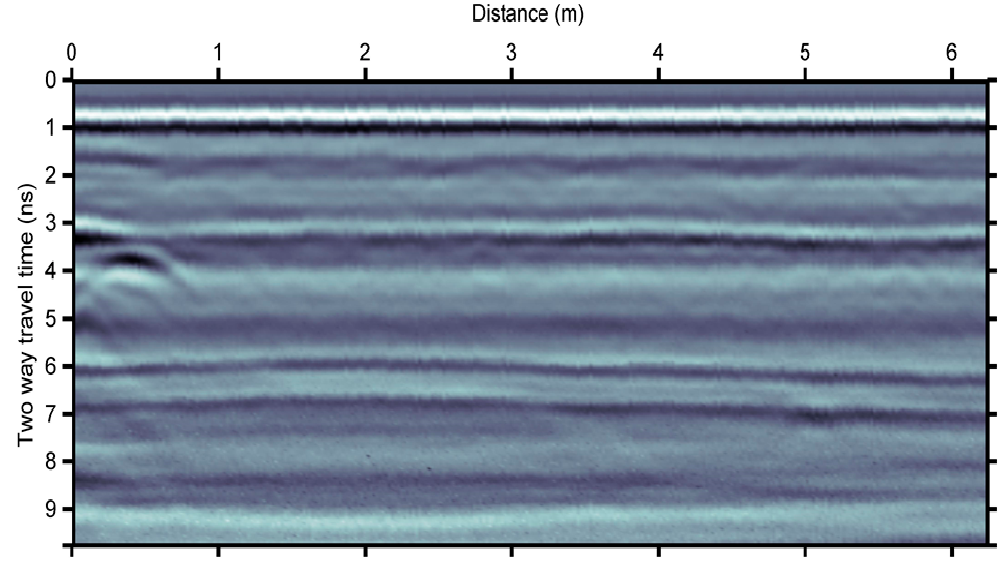
Figure 8. The GPR section represented in Figure 6 after the application of the IAD gain.